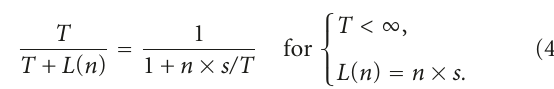
Figure 5(c) plots the optimal n for di ff erent values of T/s . Larger T/s will drive the optimal n towards larger